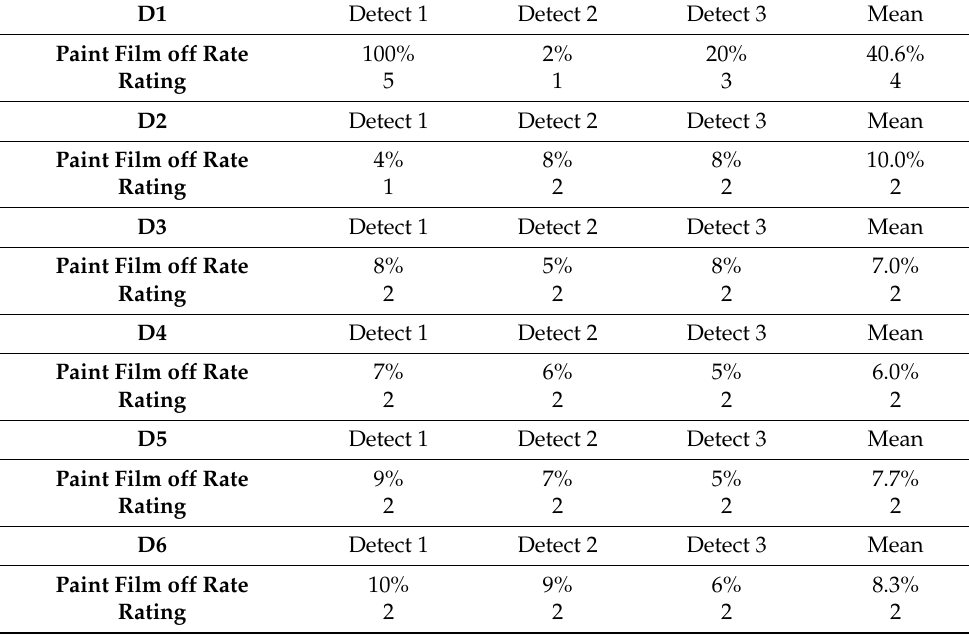
Table 12. The measured value of adhesion of paint film for Group